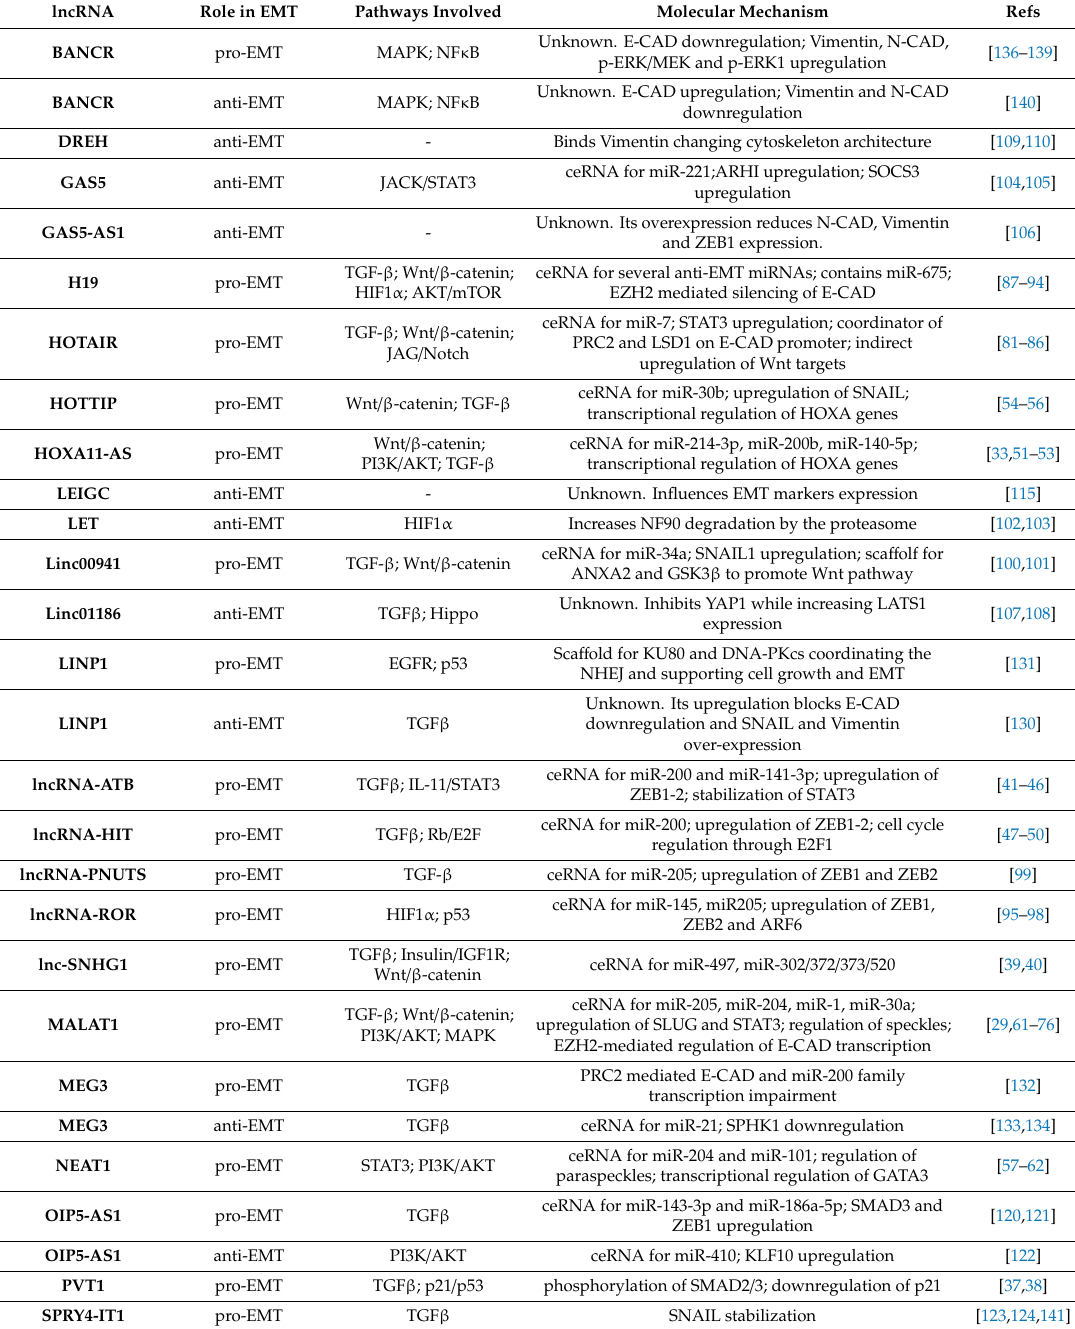
Table 1. Summary of the described lncRNAs involved in EMT regulation.